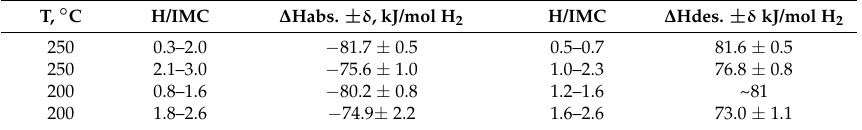
Table 2. The values of hydrogen absorption and desorption enthalpy in the Sm 2 Fe 17 -H 2 system.